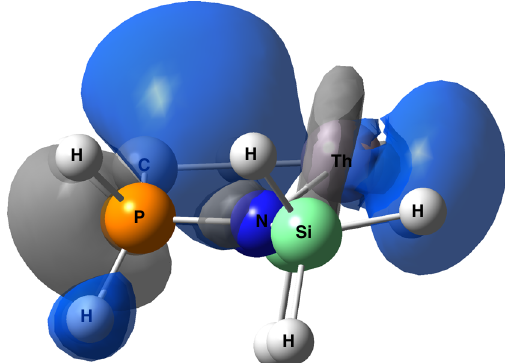
Fig. 6 NLMO of [C] = Th 2 + . This NLMO has signi fi cant amplitude in the trans direction, resulting in a cis directing effect. The orbital is 16.86% Th character, and that component is composed of 19.77% 7s, 63.88% 6d, and 16.05%